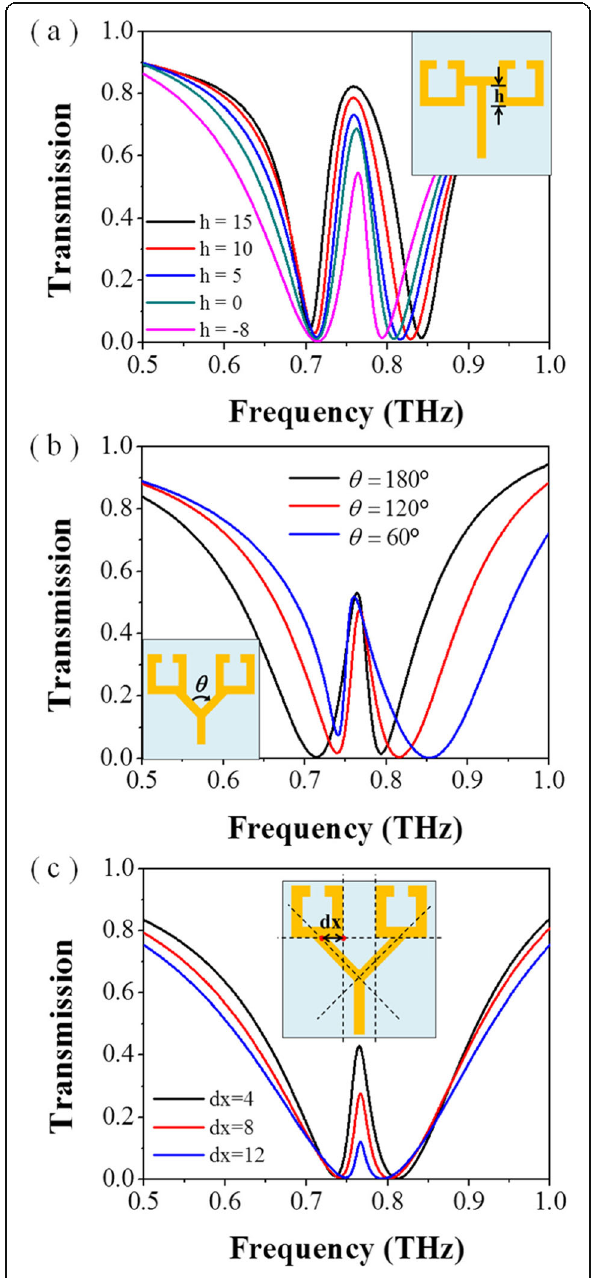
Fig. 8 Simulated spectra of the conductively coupled terahertz EIT metamaterial a when the point connecting the bar resonator and the SRRs moves upward, b when the connecting bar in the middle is bent, c when the point connecting the bar resonator and the SRRs moves toward